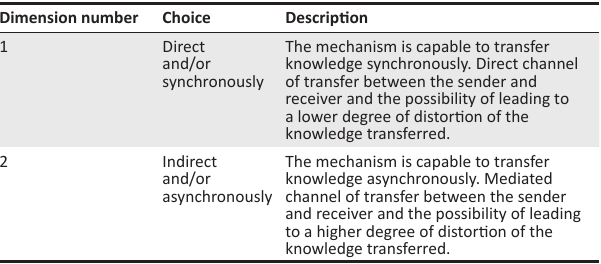
TABLE 5: Mediation dimension. Dimension number